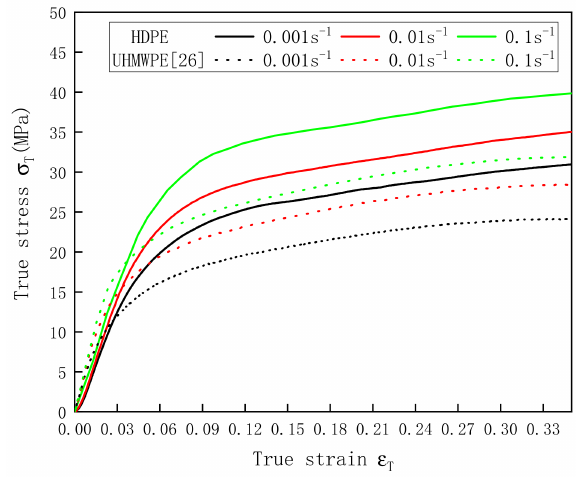
Figure 4. Stress–strain curves of HDPE and UHMWPE at strain rates of 0.001–0.1 s − 1 .